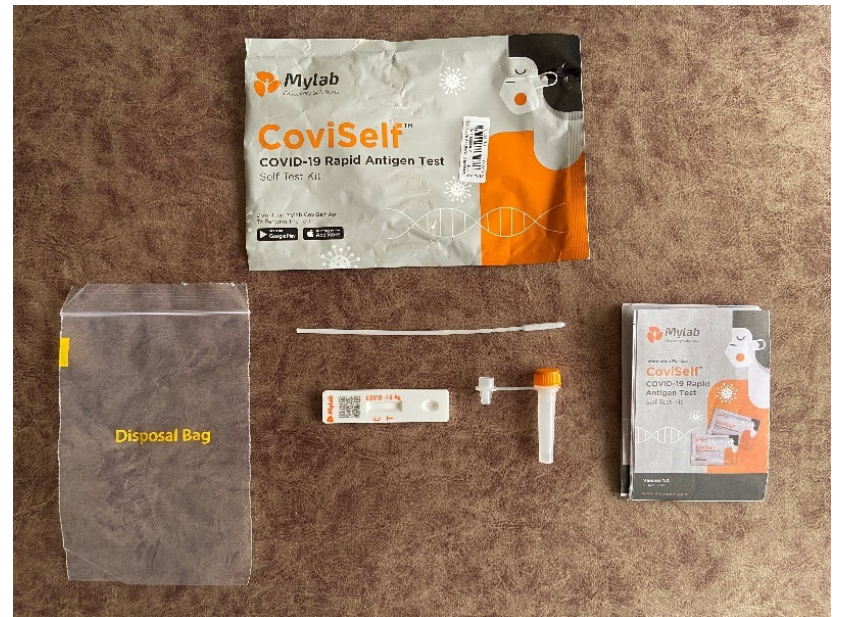
Figure 1. The components of the self-administered CoviSelf RAT kit. (Showing in clockwise order from the bottom left-hand side: the plastic bag for disposing of used items, the CoviSelf package, the instruction leaflet and, in the centre, the sterile nasal swab, the test card and the pre-filled extraction tube.) Source: Ms Anusha Kesarkar-Gavankar, photograph of 18 November